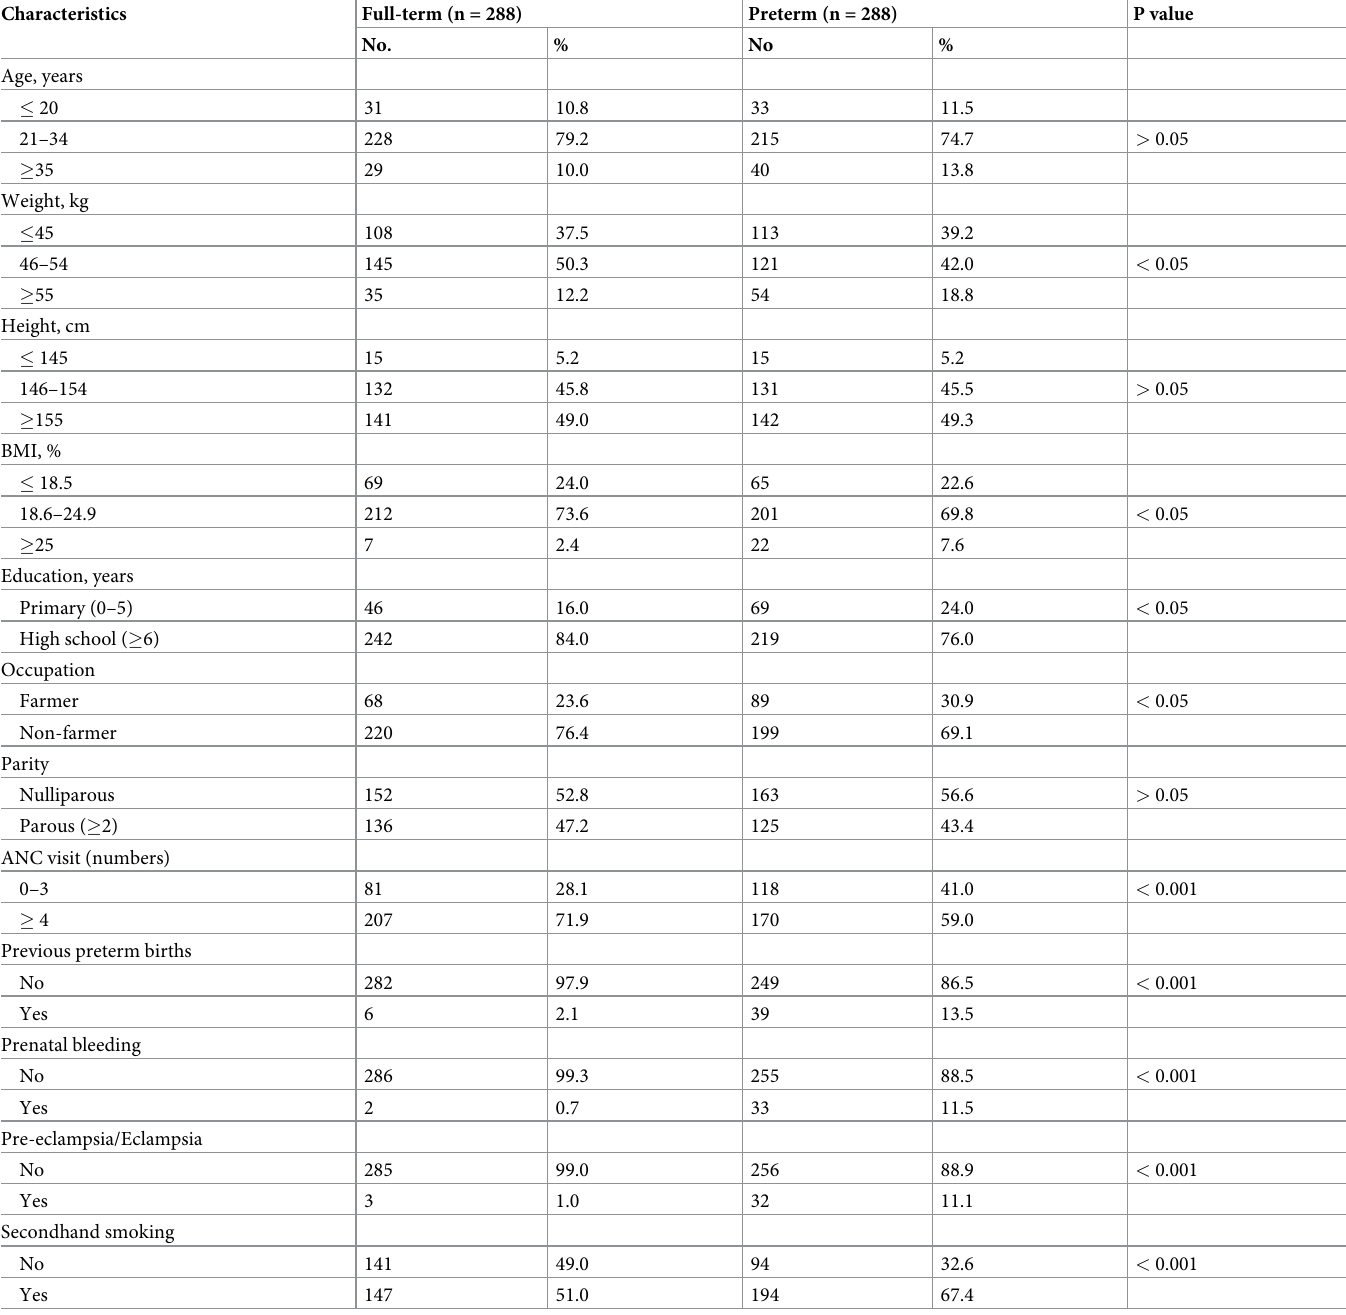
Table 1. Association between socio-demographic, reprodutive and pregnancy-related factors and preterm birth.